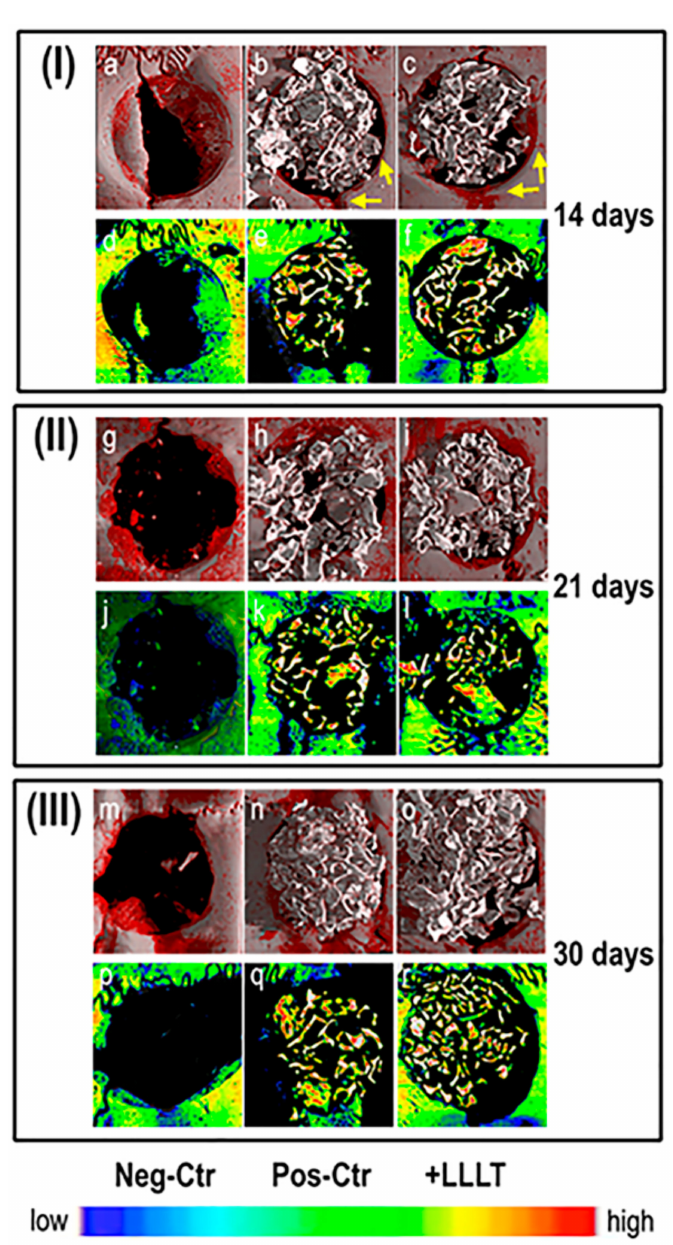
Figure 1. Micro-CT images of repaired sites in representative retrieved samples. ( a – f ) Group I: samples harvested after 14 days: ( a – c ) 3D reconstructions: ( a ) negative control (NC); ( b ) positive control (PC); ( c ) treated with low-level laser therapy (LLLT); ( d – f ) transversal sections of the defect: ( d ) NC; ( e ) PC; ( f ) treated with LLLT. ( g – l ) Group II: samples harvested after 21 days: ( g – i ) 3D reconstructions: ( g ) NC; ( h ) PC; ( i ) treated with LLLT; ( j – l ) transversal sections of the defect: ( j ) NC; ( k ) PC; ( l ) treated with LLLT. (m – r) Group III: samples harvested after 30 days: ( m – o ) 3D reconstructions: ( m ) NC; ( n ) PC control; ( o ) treated with LLLT; ( p – r ) transversal sections of the defect: ( p ) NC; ( q ) PC; ( r ) treated with LLLT. In 3D reconstructions grey tissue is mature bone; red tissue is bone under remodeling; white tissue is xenograft biomaterial; yellow arrows point to newly formed bone on defect border. In the transversal sections of the defect: white tissue is xenograft biomaterial; colors represent mineralization of the bone proportional to the color map in the bottom. Color map: blue stands for low mass density; red stands for high mass